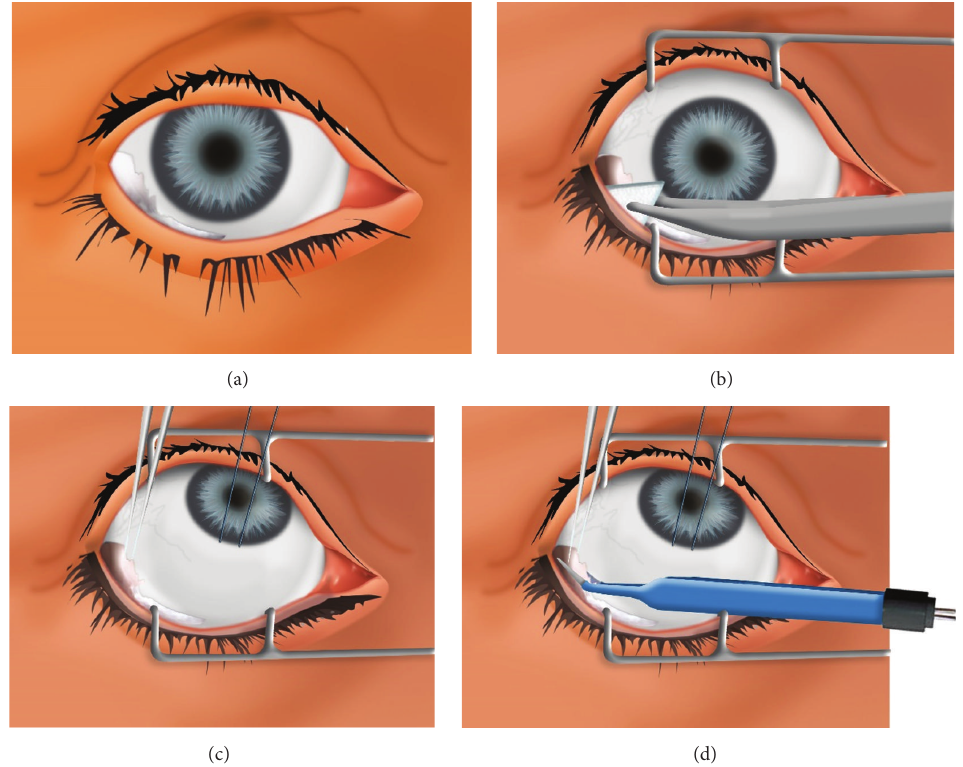
Figure 2: Figure illustrating the surgical technique. (a) Eye globe with temporal conjunctival fold. (b) Small pieces of Weck cel are placed deep into the inferior fornix. (c) The fold is grasped at the center. (d) Heat is applied at the base of the fold with the electrocautery